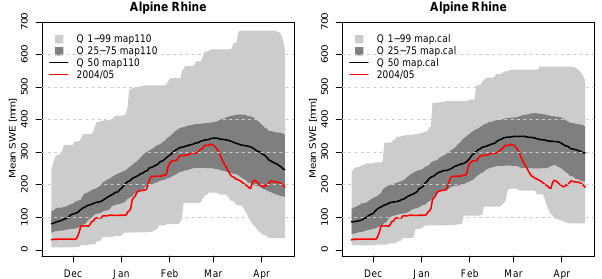
Fig. 13. SWE range (Q1–99) and interquartile range (Q25–75) for the period 1971–2009 in the Alpine Rhine catchment from map110 (left) and map.cal (right). The climatologies are calculated for daily mean SWE with a window of ± 10 days around the day of interest. The red line is SWE for the year 2004/2005, based on